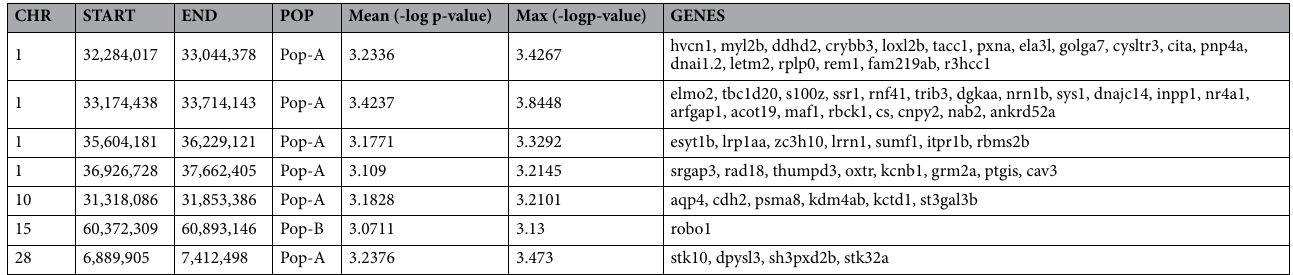
Table 2. Genome regions and genes spanning the detected selection signatures by XP-EHH in each population.